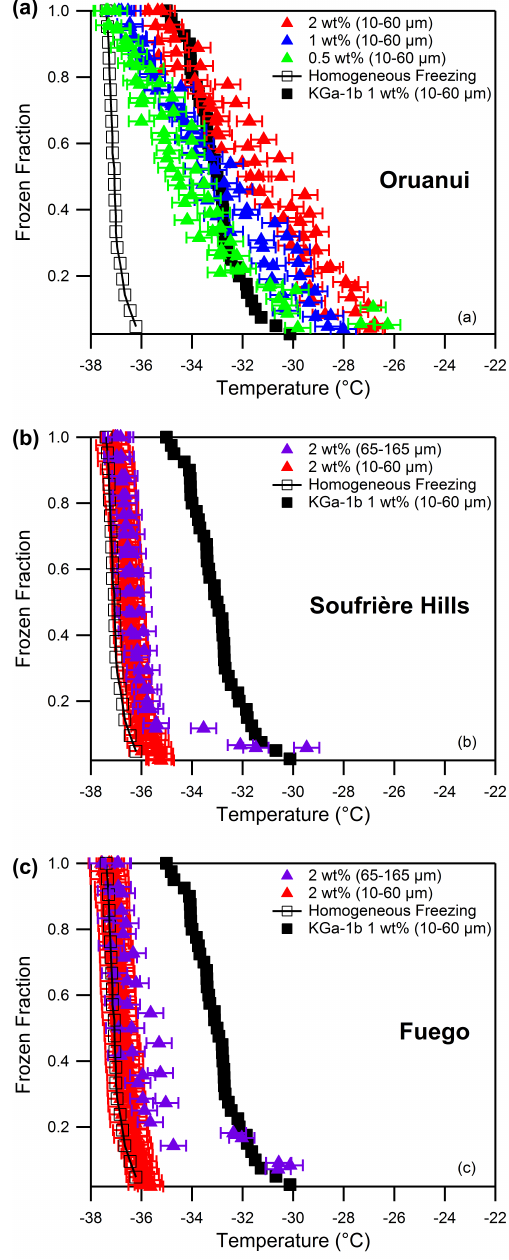
Figure 7. Frozen fraction curves as a function of temperature for 0.5, 1.0, and/or 2wt% Oruanui ash (a) , Soufrière Hills (b) , and Fuego Ash (c)